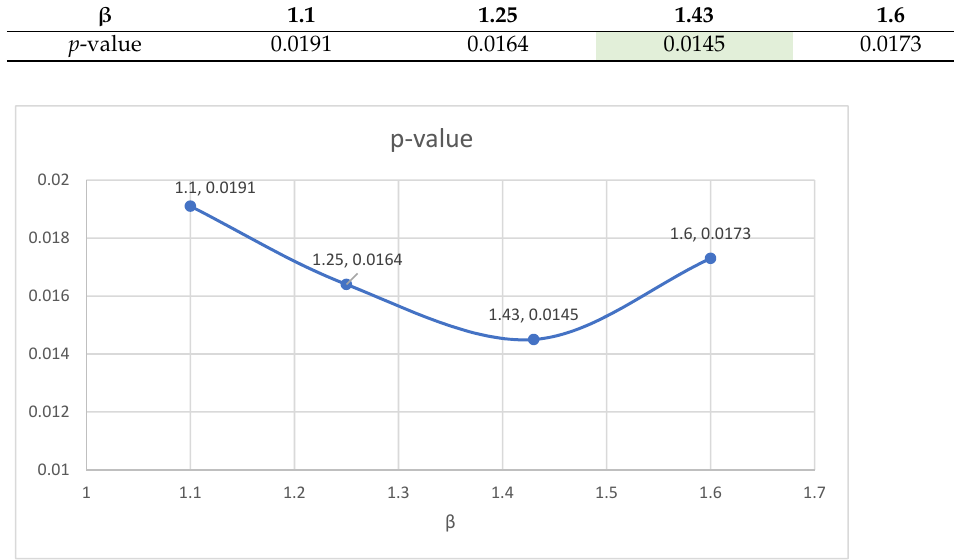
Table 3. The p -value in F-test and t -test . Set a vs. Set a ′ Set b vs. Set b ′ Set c vs. Set c ′